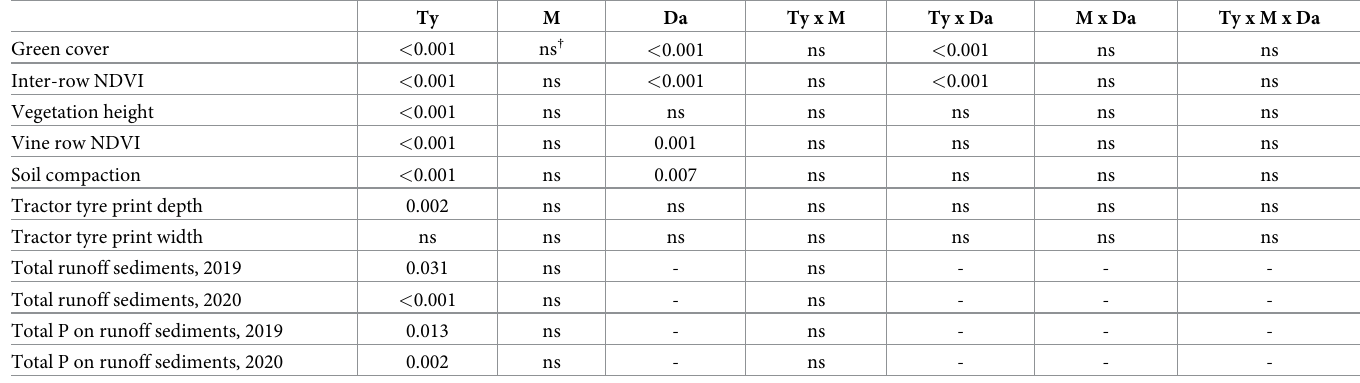
Table 5. Results of the analysis of variance on the effects of type of inter-row vegetation (Ty), mulching treatment (M), and sampling date (Da), and their interac- tions on a) vegetation height, percentage green cover, and inter-row NDVI; b) vineyard NDVI, soil compaction, tractor tyre print depth, and tractor tyre print width; and c) total runoff sediments in 2019 and in 2020, and total P in runoff sediments in 2019 and